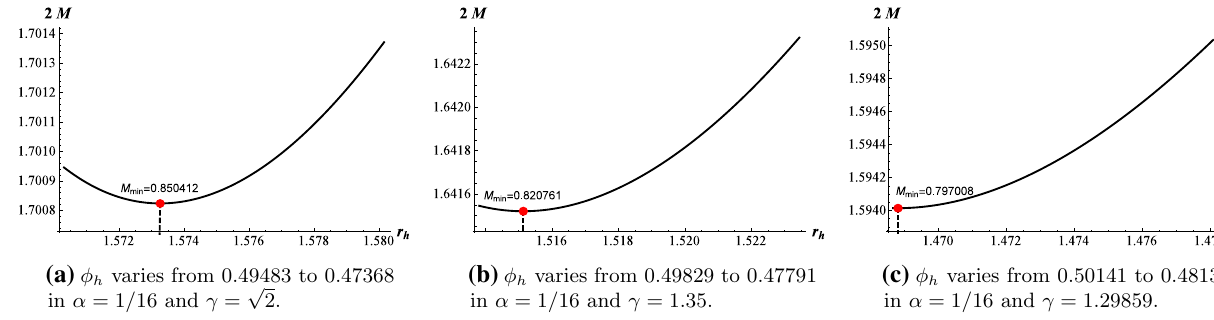
Fig. 1 The horizon versus mass of the dilatonic black hole with different γ